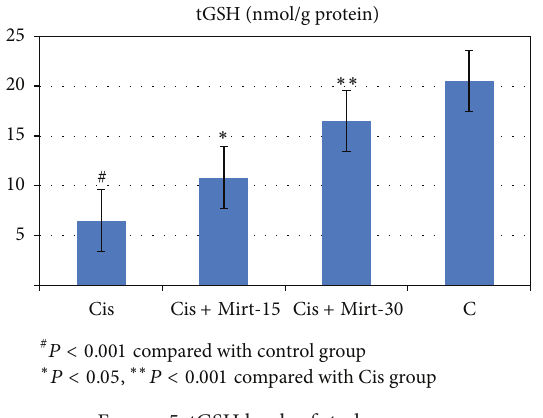
Figure 5: tGSH levels of study groups.